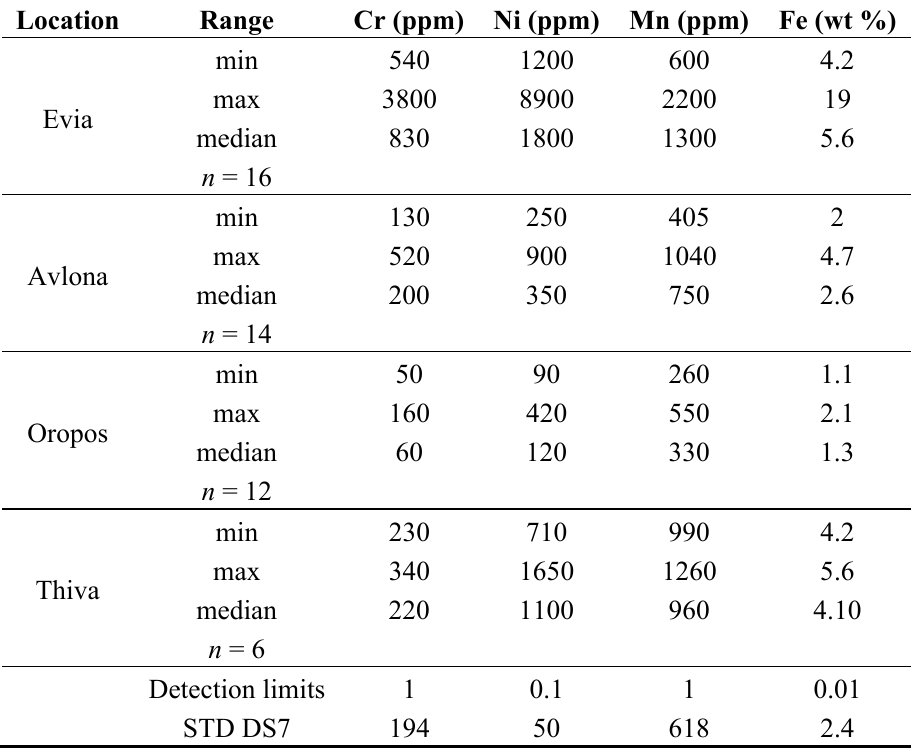
Table 1. Range and median of major and trace element contents in soils from the Assopos-Thiva basins and central Evia. Data from [18–22].